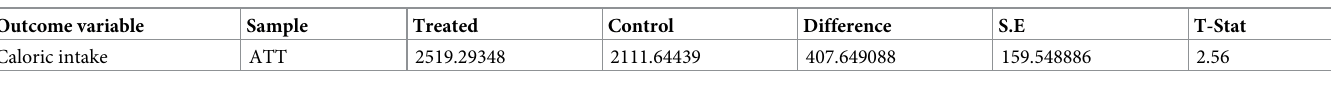
Table 10. Impact of PSNP participation on household consumption using ATT.